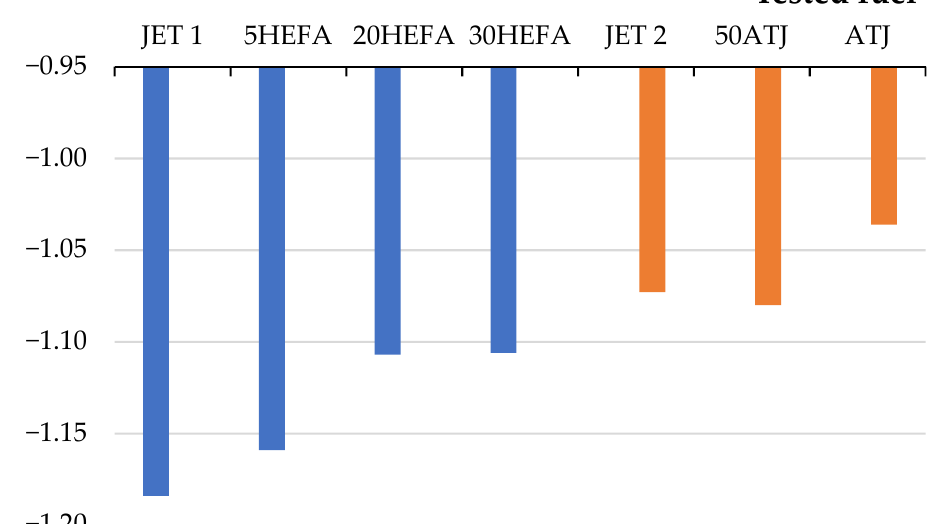
Figure 4. The influence of concentration of HEFA component in blend with Jet A-1 on the n parameter.